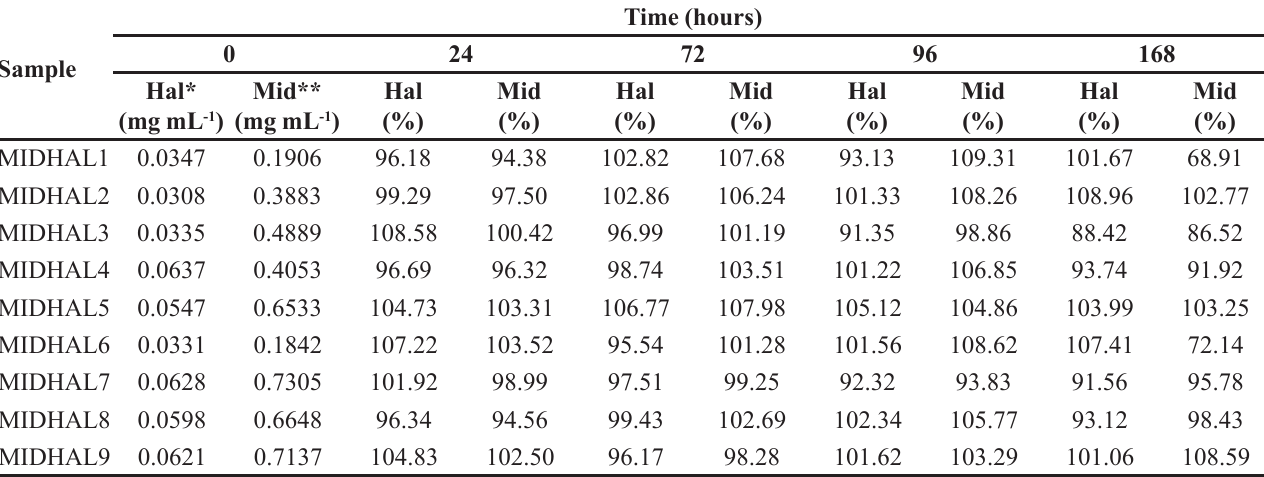
TABLE IV - Mean percentages values of drugs concentrations at time zero and remaining percentages in the admixtures at different